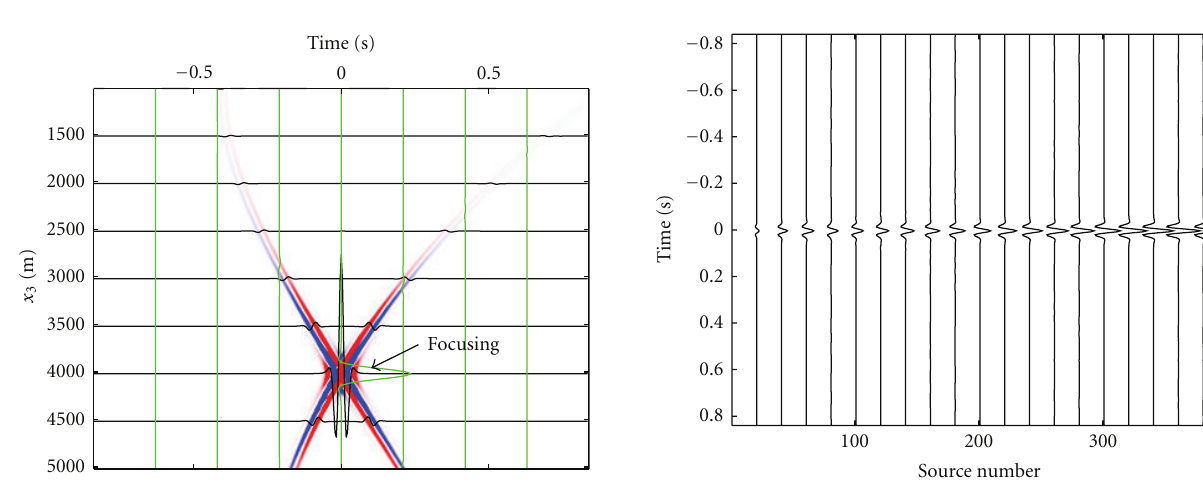
Figure 24: PSF correlation gather for receivers at x A = = x = (15000m,4000m) and x (cid:7) A A